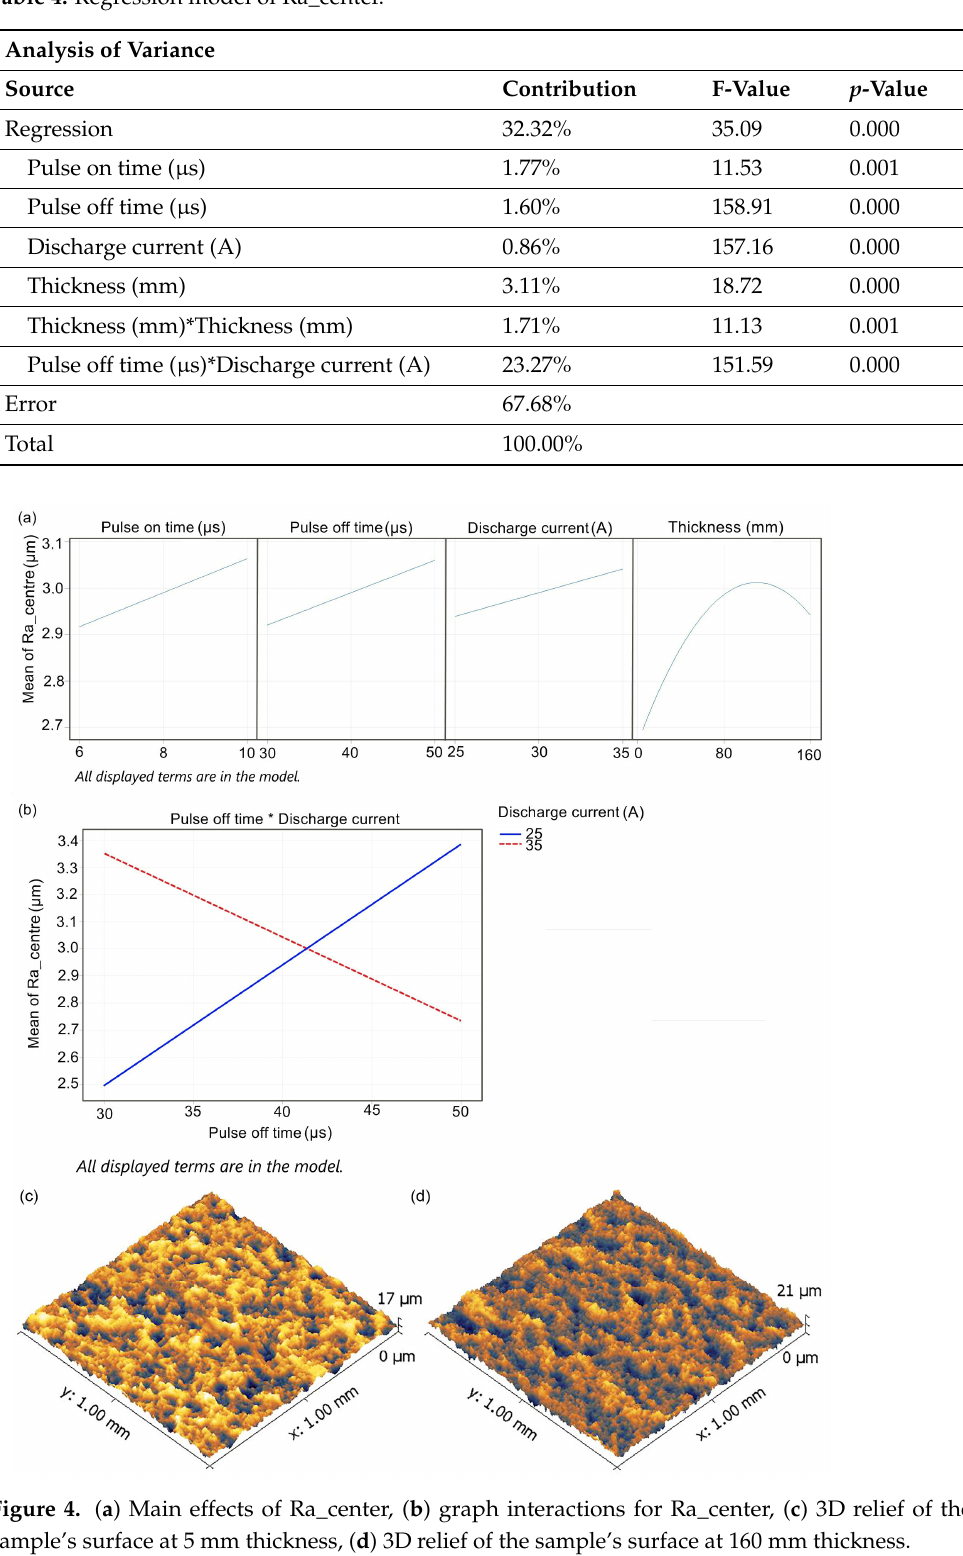
Table 4. Regression model of Ra_center.